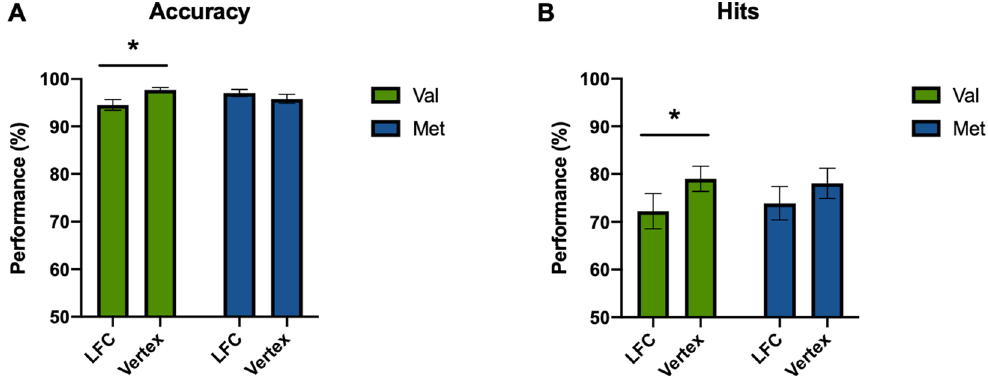
Figure 2. TMS effects on cognition as a function of BDNF Val66Met gene polymorphism. Cognitive performance results considering ( A ) accuracy during encoding as well as ( B ) hits during recognition. Statistical analyses were performed via one-way repeated measures ANOVAs with experimental conditions as within- subject factor and BDNF Val66Met gene polymorphism as between-subject factor. Subsequent pair-wise analyses were conducted with t-tests. * Significant differences (p < 0.05). LFC, left frontal